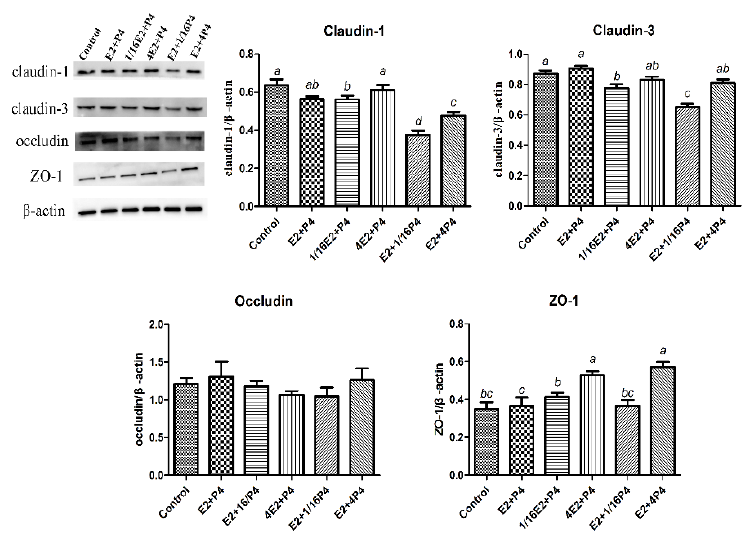
Figure 4. The effect of the E 2 and P 4 treatment on the protein expression of claudin-1, claudin-3, occludin, and ZO-1. Western blot analysis and densitometry quantification of claudin-1, claudin-3, occludin, and ZO-1 expression normalized to the total β -actin in the GMECs. These experiments were repeated at least three times. Data are represented as the means ± SD; values with different letters differed significantly ( p < 0.05).